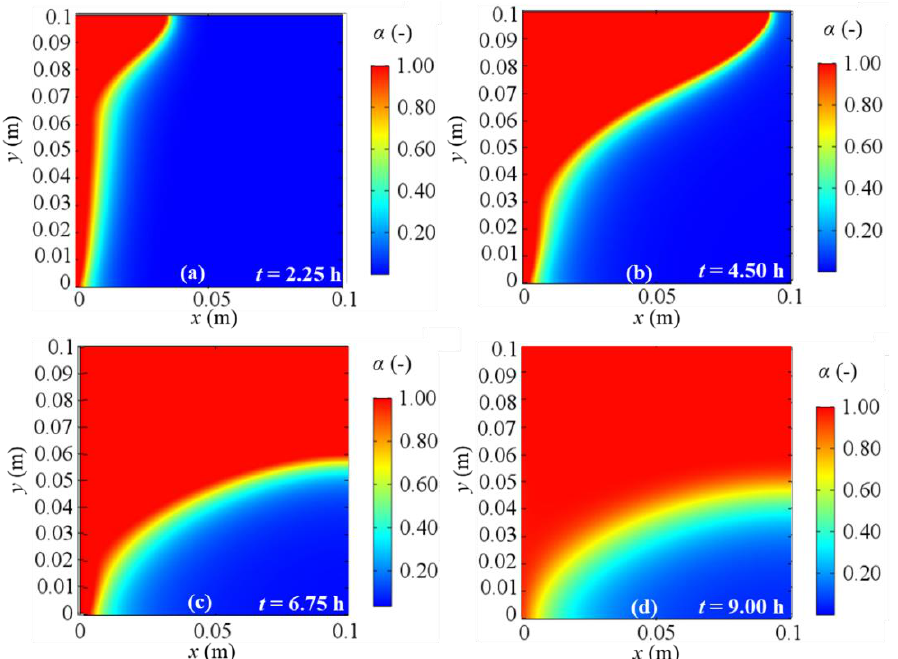
Figure 16. Melting fraction evolution for 2D model with natural convection and BC 3 at different evaluation times: ( a ) after 2.25 h; ( b ) after 4.50 h; ( c ) after 6.75 h; ( d ) after 9.00 h from the simulation beginning respectively.